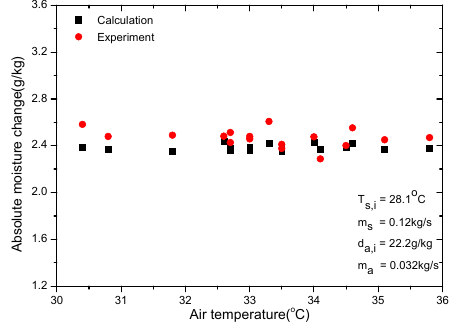
Figure 5. Influence of air temperature on dehumidification performance.